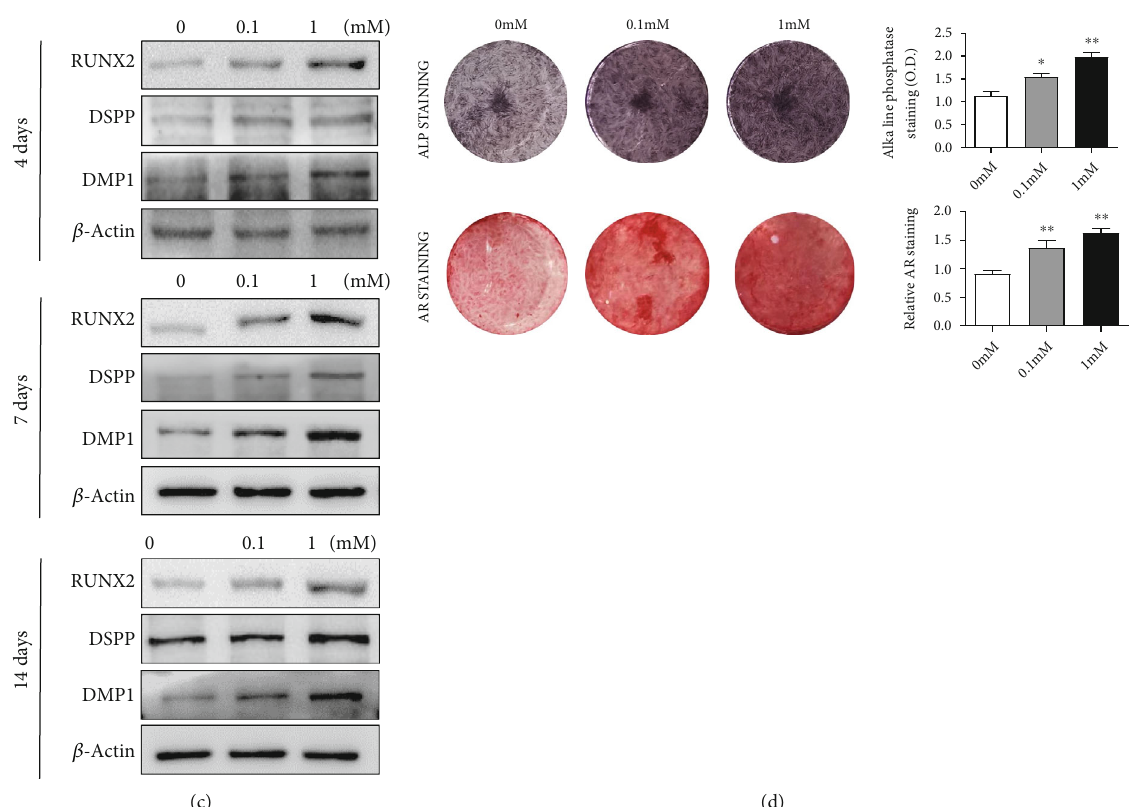
Figure 3: The impact of Neu5Ac on DPSC osteo-/odotoblastic di ff erentiation. (a) CCK-8 assay results of Neu5Ac-treated DPSC. (b) qRT- PCR detected the expressions of DMP1, DSPP, BSP, and RUNX2 after treating DPSCs with Neu5Ac (0.1 or 1 mM) for 4, 7, or 14 days, with GAPDH used as a normalization control. (c) DMP1, DSPP, and RUNX2 protein expressions were detected by western blotting. (d) The ability of DPSC with Neu5Ac treatment (0.1 and 1 mM) assessed via ALP activity and Alizarin red staining. Data are means ± SD . ∗ p < 0 : 05 , ∗∗ p < 0 : 01 , or ∗∗∗ p < 0 : 001 . All the experiments were repeated at least three times